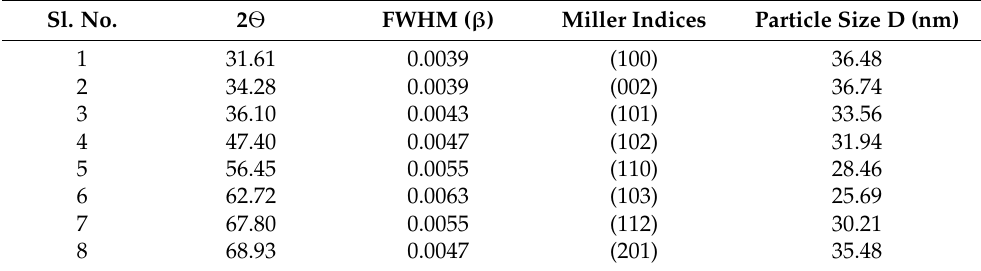
Table 1. Crystal planes and particle size details from the XRD analysis of ZnO nanoparticles synthe- sized using Acacia caesia (L.) Willd. at different diffraction angles. Sl.